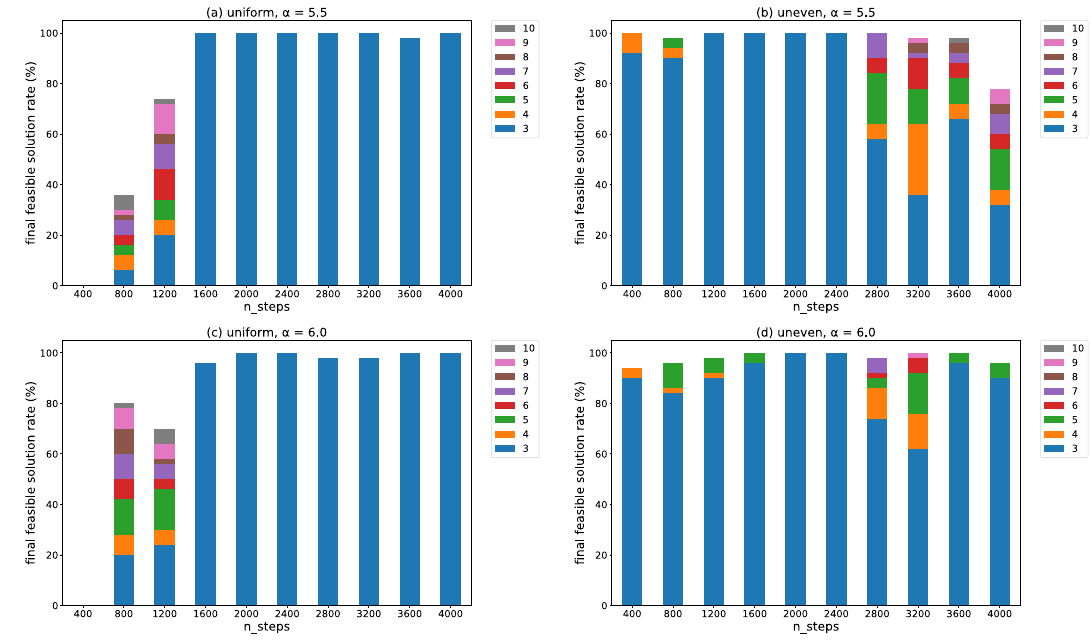
Figure 5. Final feasible solution rates for ( a , c ) the uniformly distributed data set and ( b , d ) the unevenly distributed one. The number in the legend is the number of iterations of steps 2–4 in the iterative fractional-cost method. The horizontal axis represents the number of SB time steps. The hyperparameters α = 5.5 in ( a , b ), and α = 6.0 in ( c , d ).